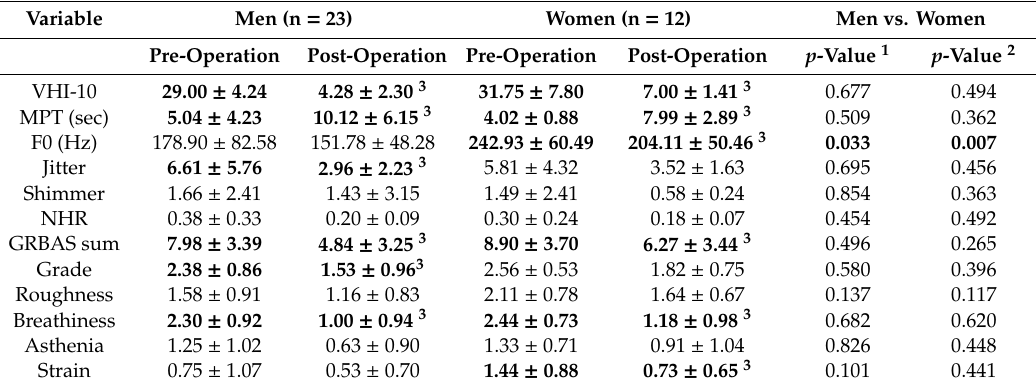
Table 4. Subgroup comparisons of parameters between men and